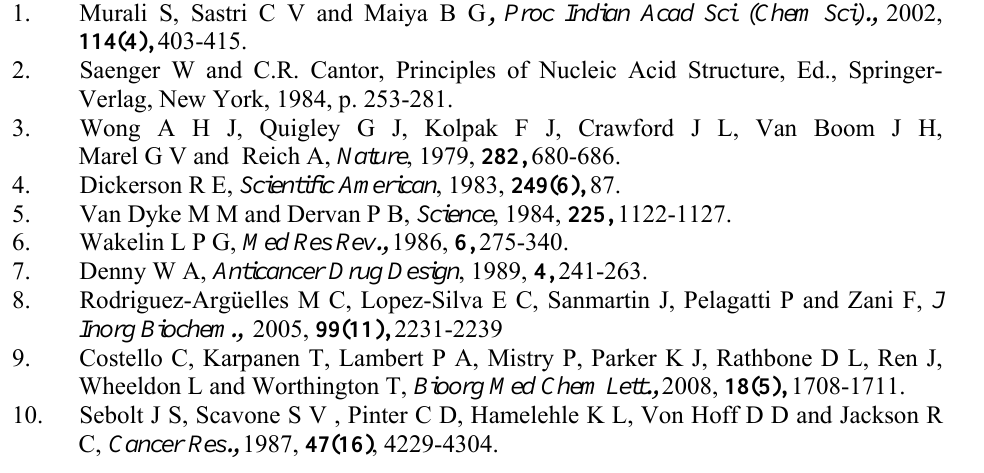
O were added, respectively, incubation at 2 2 O (control); Lane 3 : DNA + 2 2 O ; Lane 5: DNA + [Cu(BMOT) ]; Lane 6: DNA 2 2 2